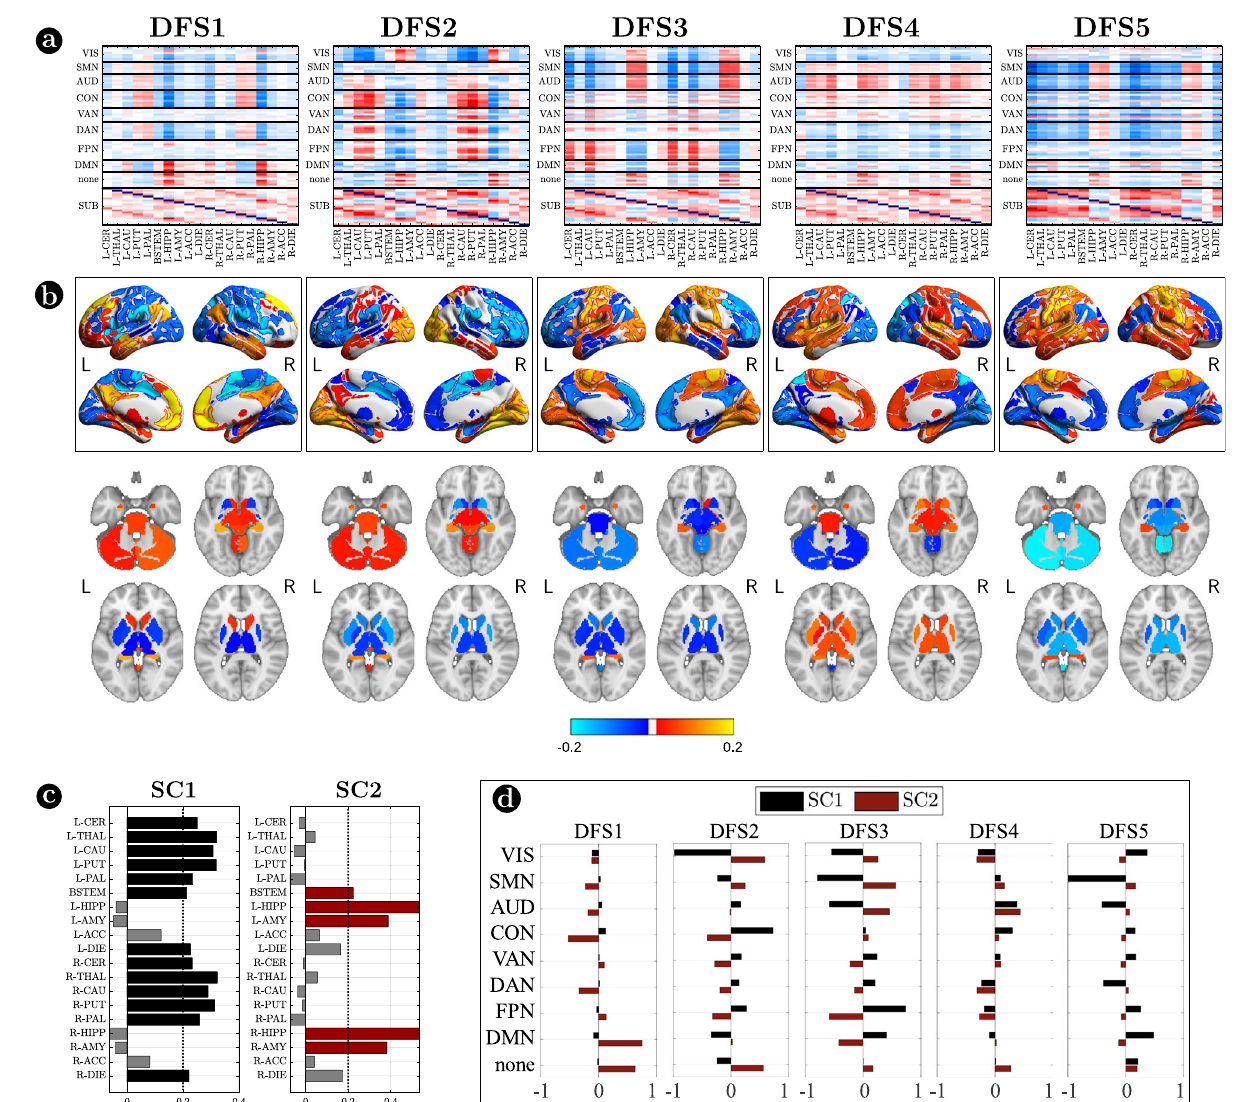
Fig.3|Cortico-subcorticalinteractioninthedynamicfunctionalstates(DFSs). a Matrixrepresentationofcortico-subcorticalinteraction.ThisisazoomofFig.2a. Positiveandnegativevaluesareindicatedwithredandblue,respectively. b Surface and volume projection of the fi rst eigenvector of each DFSs. Cortical regions are shown in surface (top), while subcortical regions in volume (bottom). c Loading of